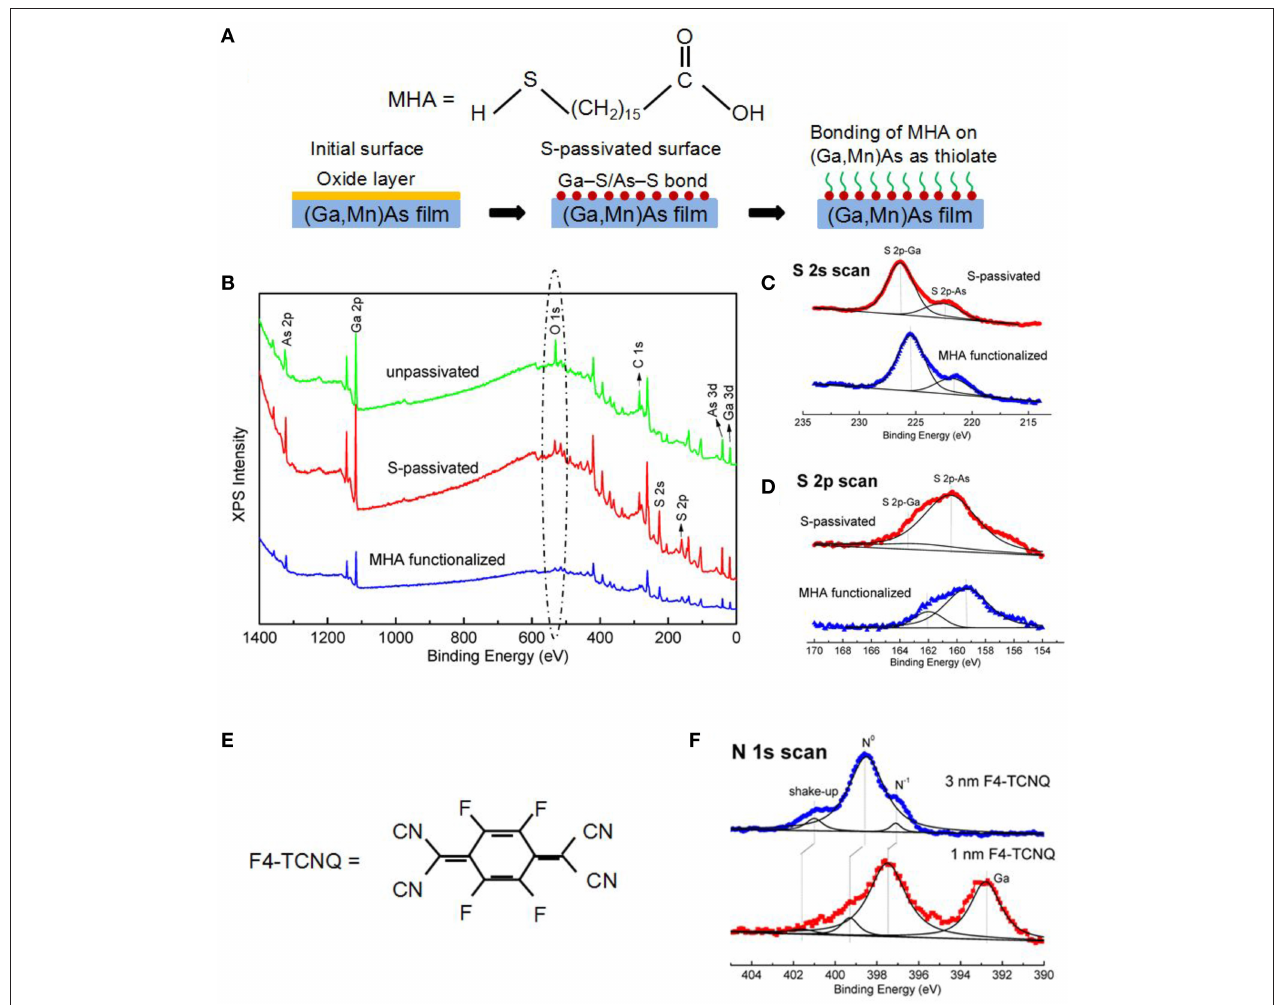
FIGURE 1 | Surface decoration of electron donor and acceptor organic molecules on (Ga,Mn)As films [54]. (A) Schematic representation of the surface modification procedures for MHA SAM. (B) XPS spectra of unpassivated, S-passivated, and MHA-functionalized GaAs samples. (C) Enlarged XPS spectra for sulfur 2 s , which show two peaks (corresponding to S 2 s -Ga and S 2 s -As respectively). (D) Magnified XPS spectra for sulfur 2 p , in which both the traces of S 2p-Ga and S 2p-As can be observed. (E) Molecular structure of F4-TCNQ. (F) The XPS spectra of N 1s core level for 1 nm monolayer and 3 nm multilayer F4-TCNQ on (Ga,Mn)As films, revealing the saturation effect of the charge transfer